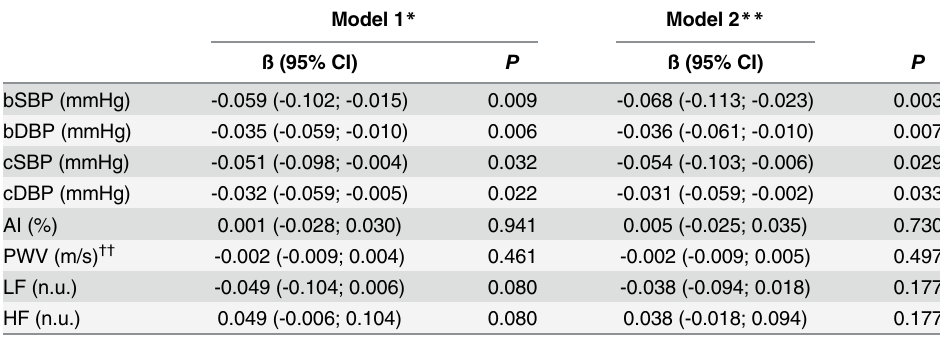
Table 3. Relationship between light physical activities and blood pressure, arterial stiffness and car- diac autonomic modulation parameters in hypertensive